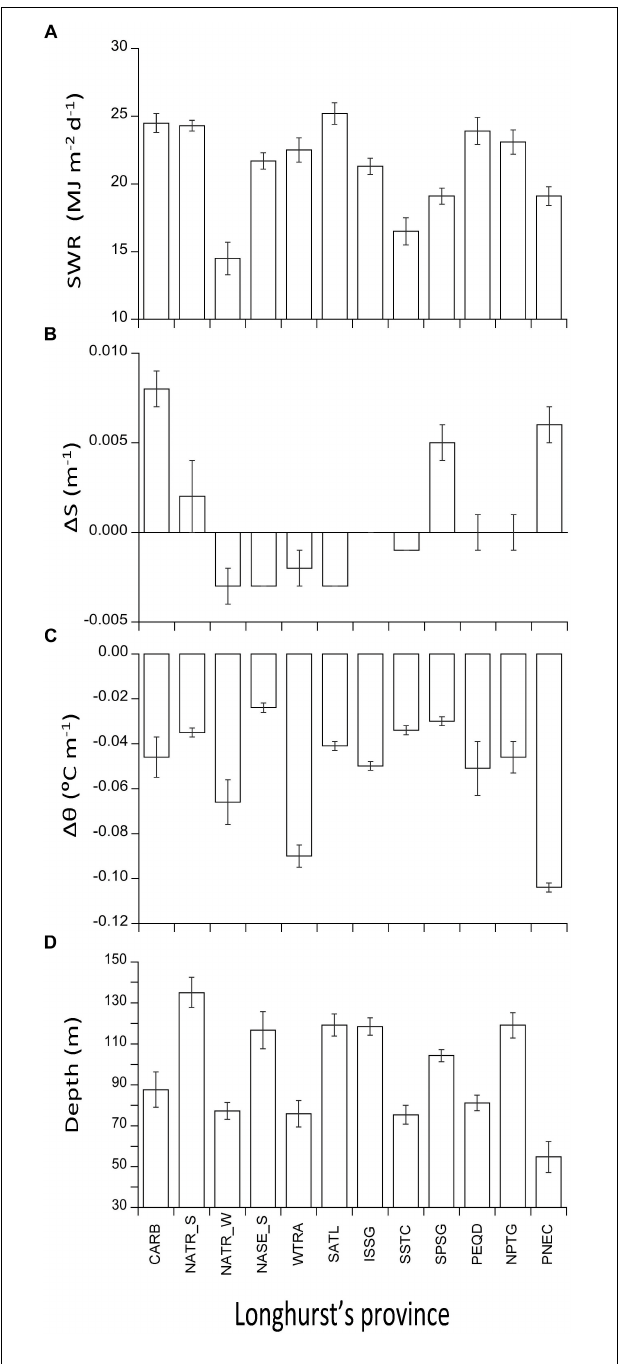
FIGURE 3 | Bar plots of the distribution of selected explanatory variables (average ± SD): (A) weekly shortwave radiation SWR (MJ m − 2 d − 1 ), (B) Gradient of salinity, DS (m − 1 ), (C) Gradient of temperature, D θ ( ◦ C m − 1 ), and (D) Depth of the DCM (m) among biogeographic provinces. Note that (B–D) are integrated with depth.